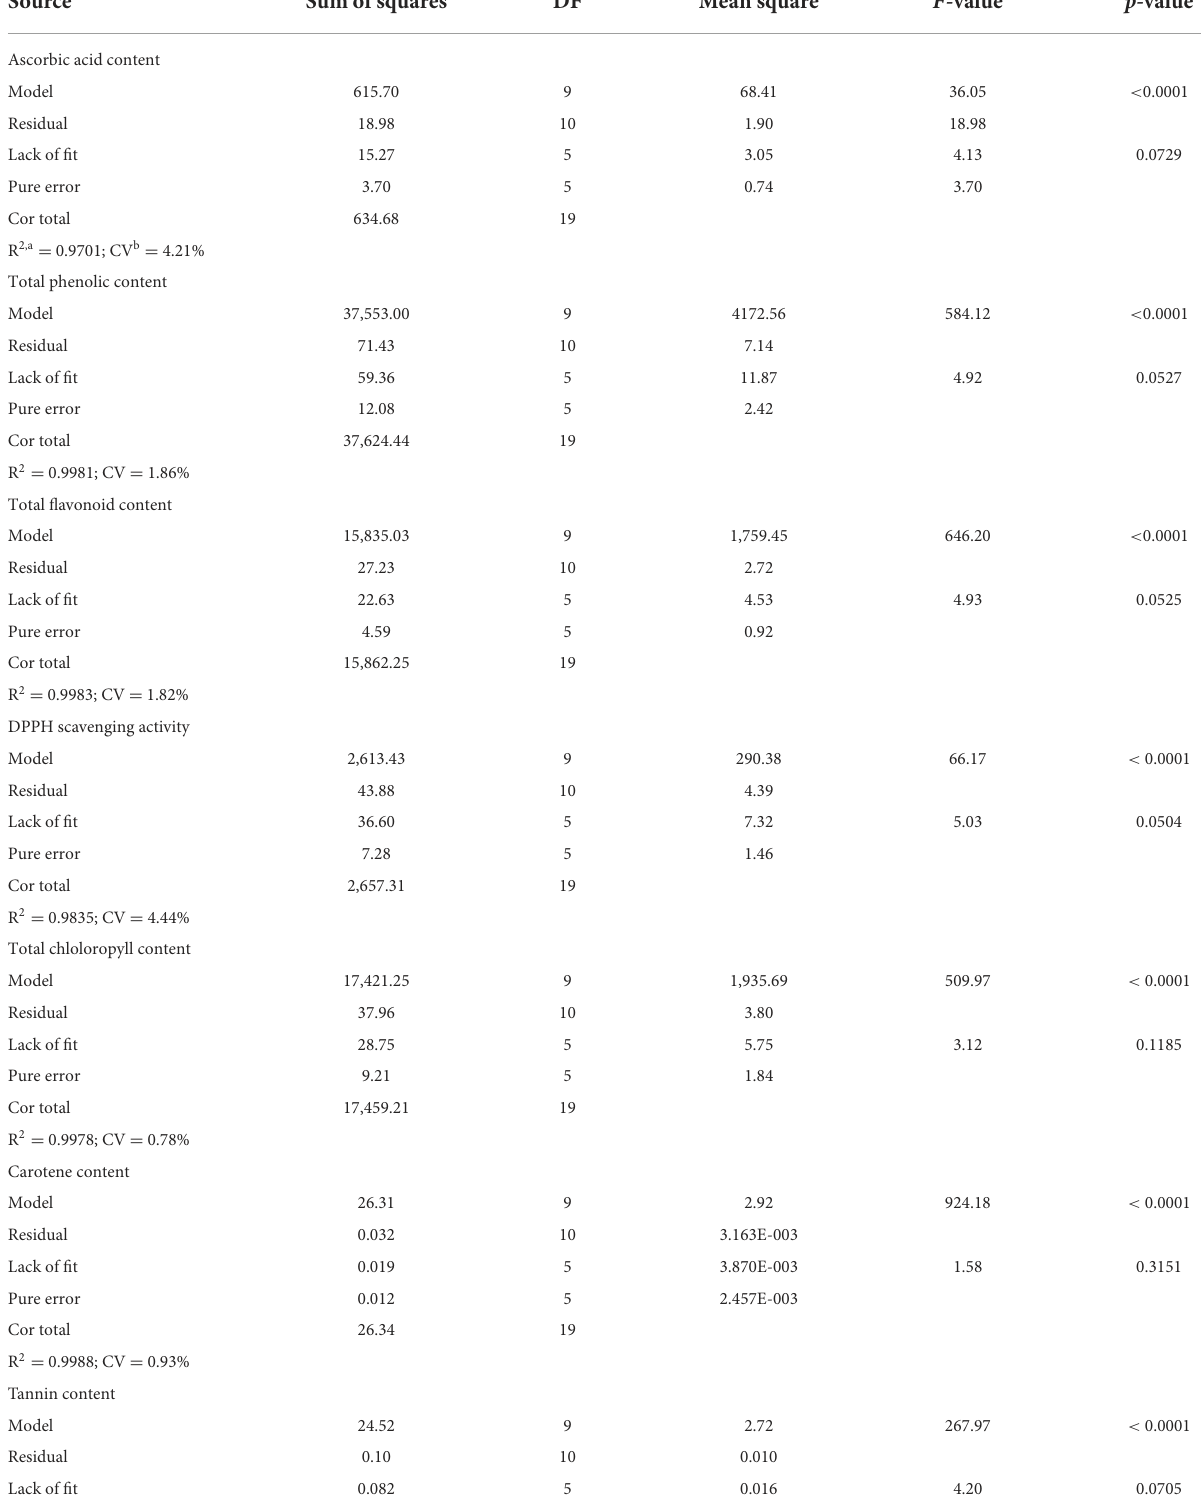
TABLE 1 Analysis of Variance (ANOVA) of the fitted second order polynomial model for various responses and second order polynomials model equations for investigated responses. Source Sum of squares DF Mean square F -value p -value Ascorbic acid